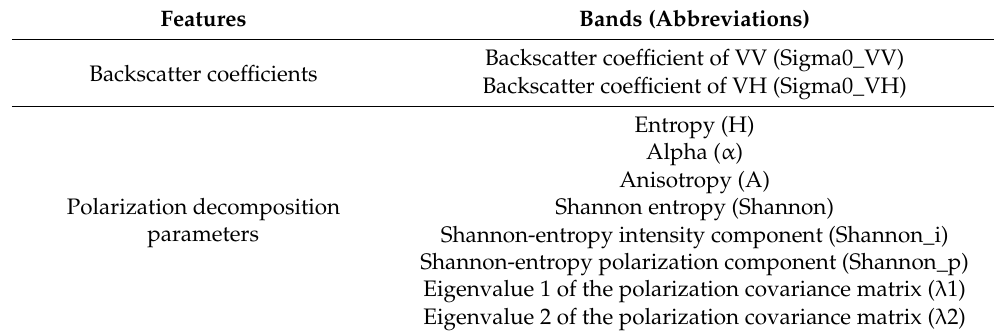
Table 3. SAR parameters extracted in this